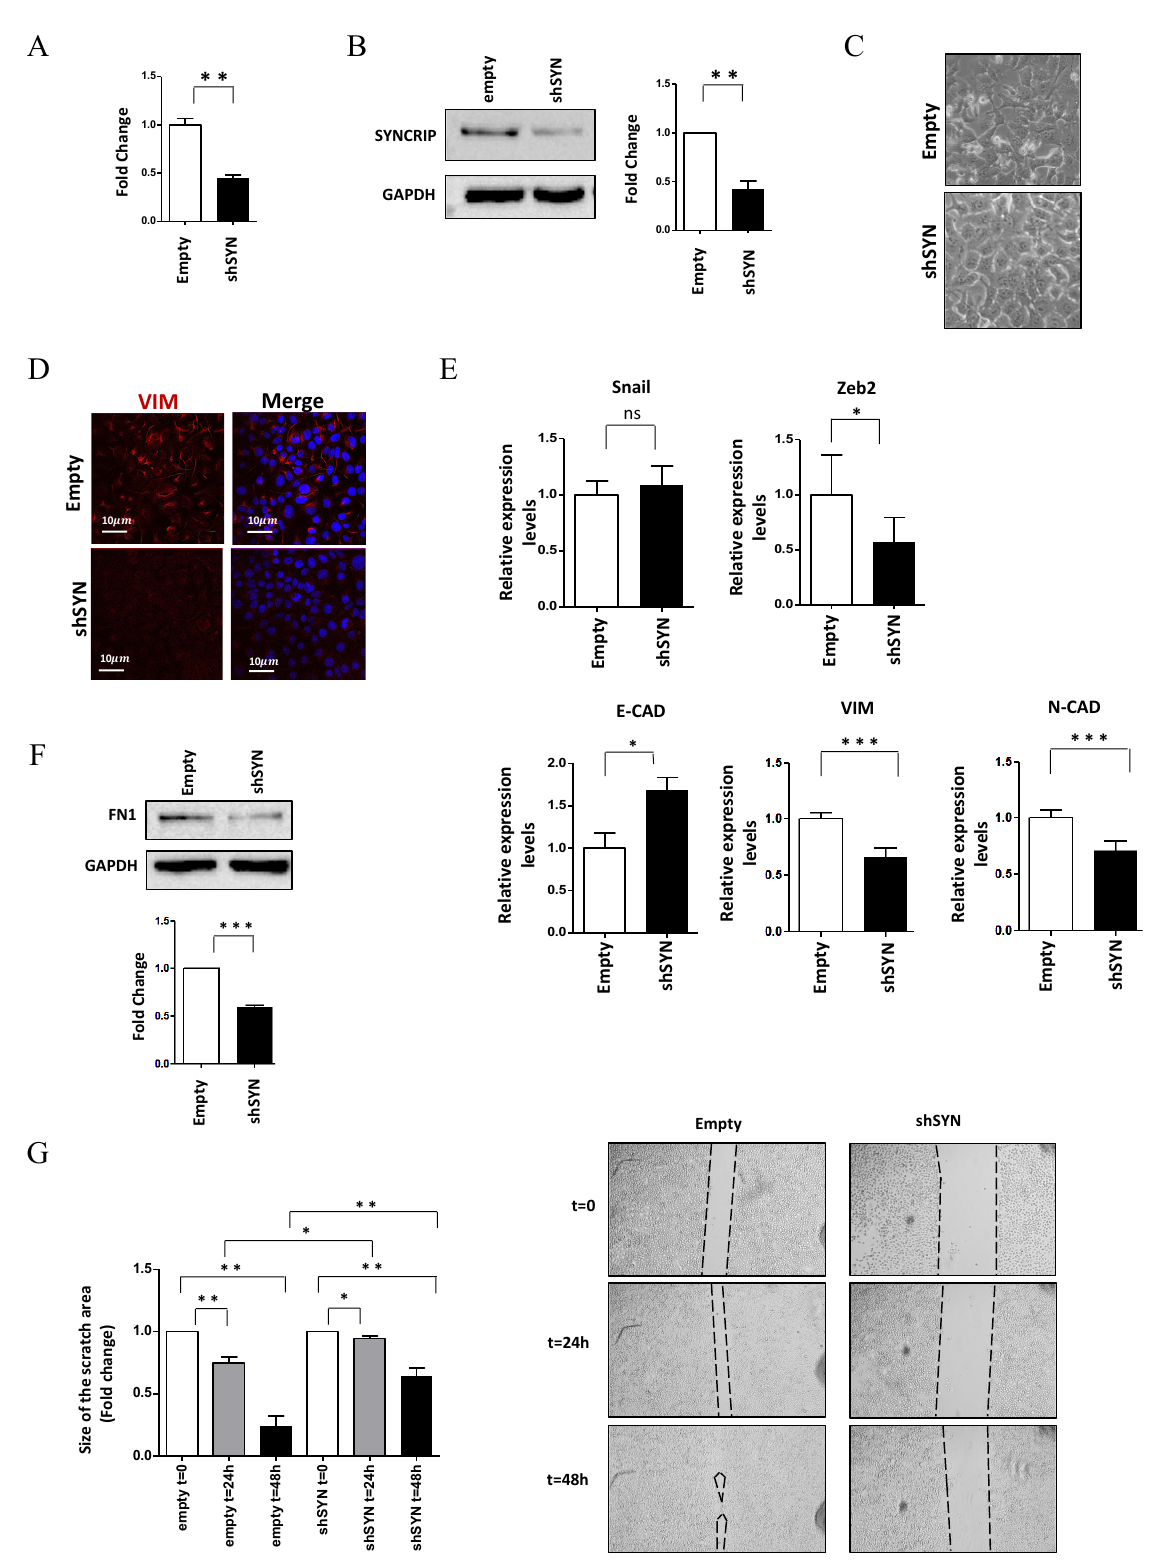
Figure 2. SYNCRIP impairment affects mesenchymal phenotype and migratory properties of HCC cells. ( A ) qRT-PCR analysis of Syncrip intracellular levels in BW1J hepatoma cells silenced for SYN- CRIP (shSYN) compared to cells transfected with the empty vector (empty). The values are